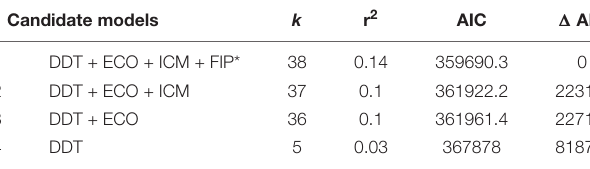
Candidate models